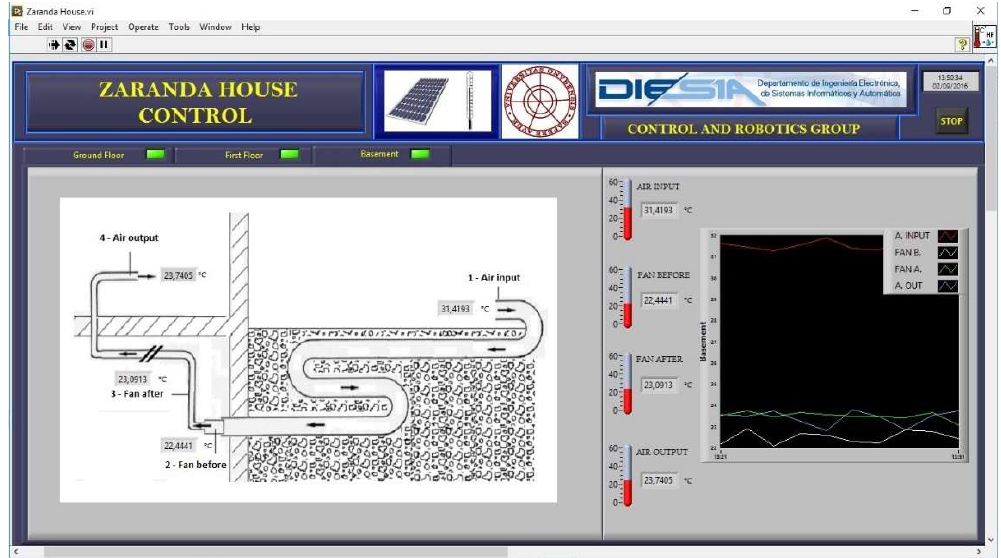
Figure 15. Location of sensors (the LEGE system) in the basement.